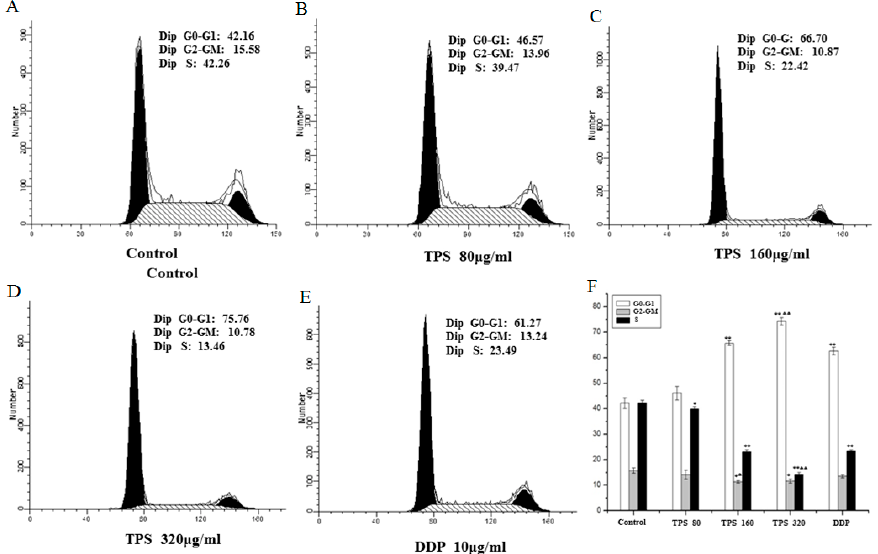
Figure 7. TPS provoked apoptosis in CT26 cells. Apoptosis rates of the control group, TPS group at indicated concentrations and positive control group DDP cells for 48 h were determined by FACS analysis ( A – E ). ( F ) Bar graphs show mean ± SD of three independent experiments. ** p < 0.01, vs. control group. ΔΔ p < 0.01 vs. DDP group.